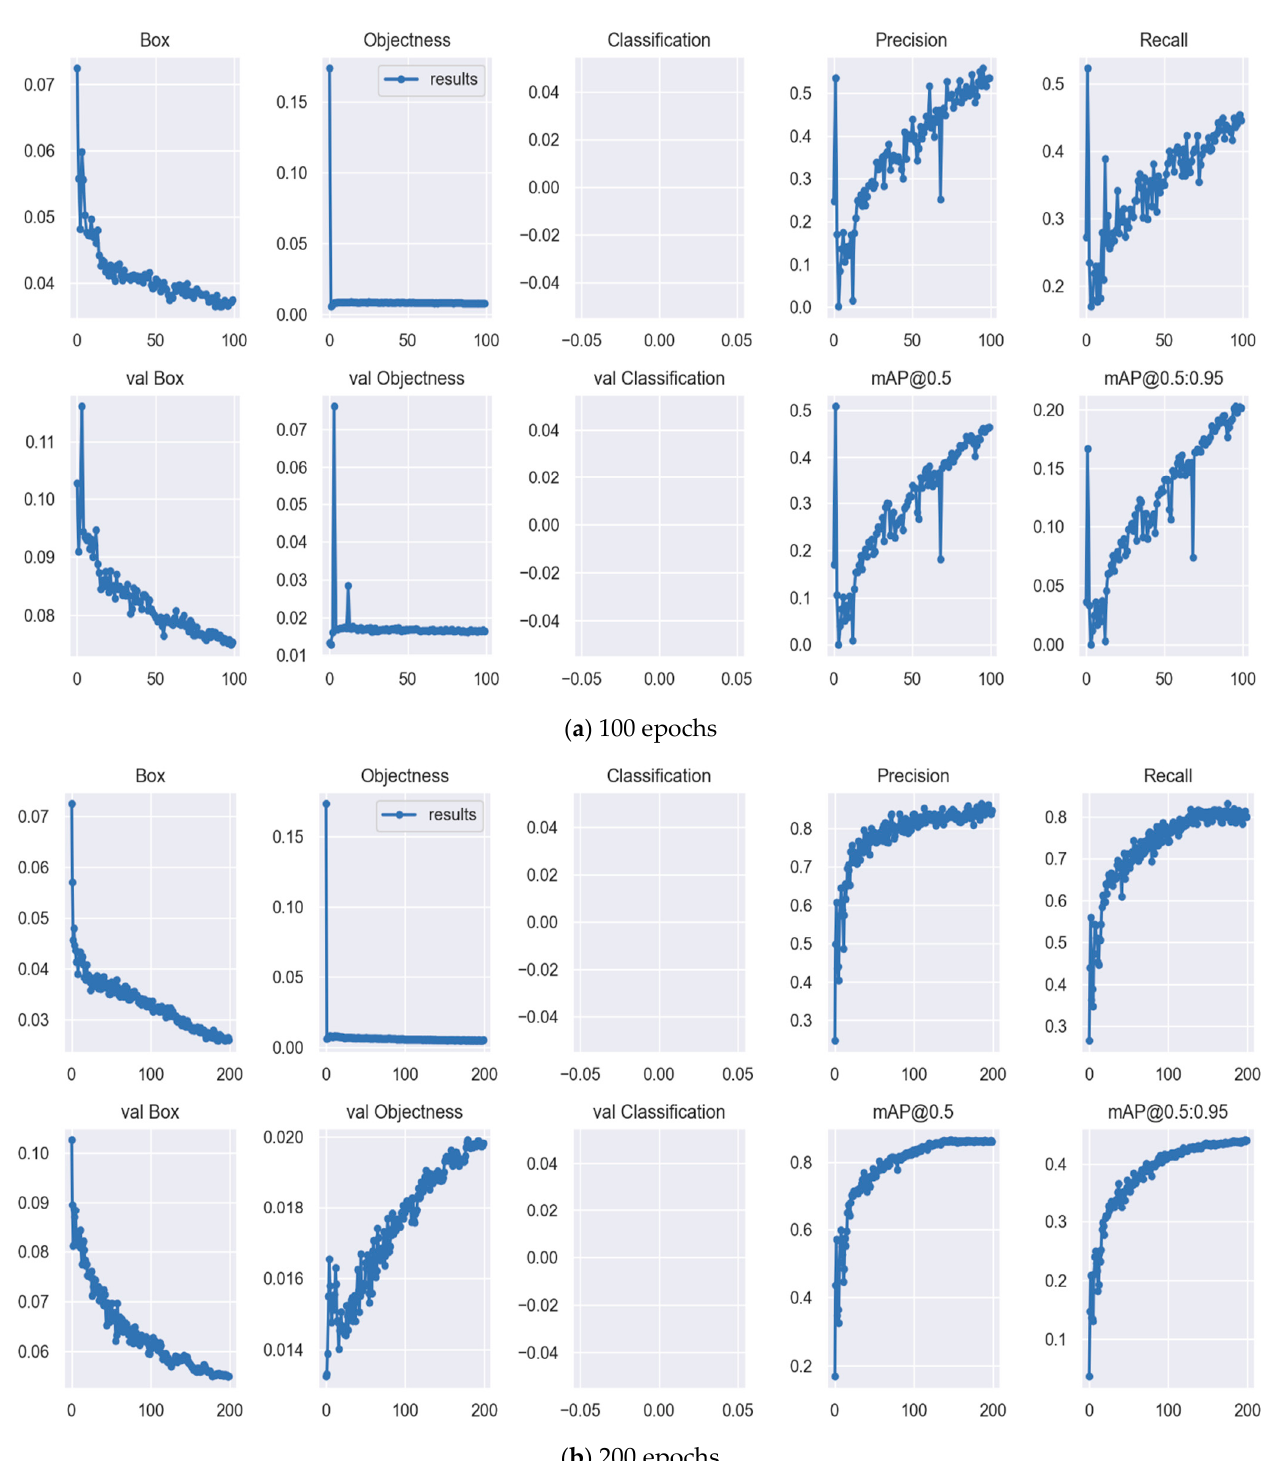
Figure 5. Yolov7x training graph with ( a ) 100 epochs and ( b ) 200 epochs.